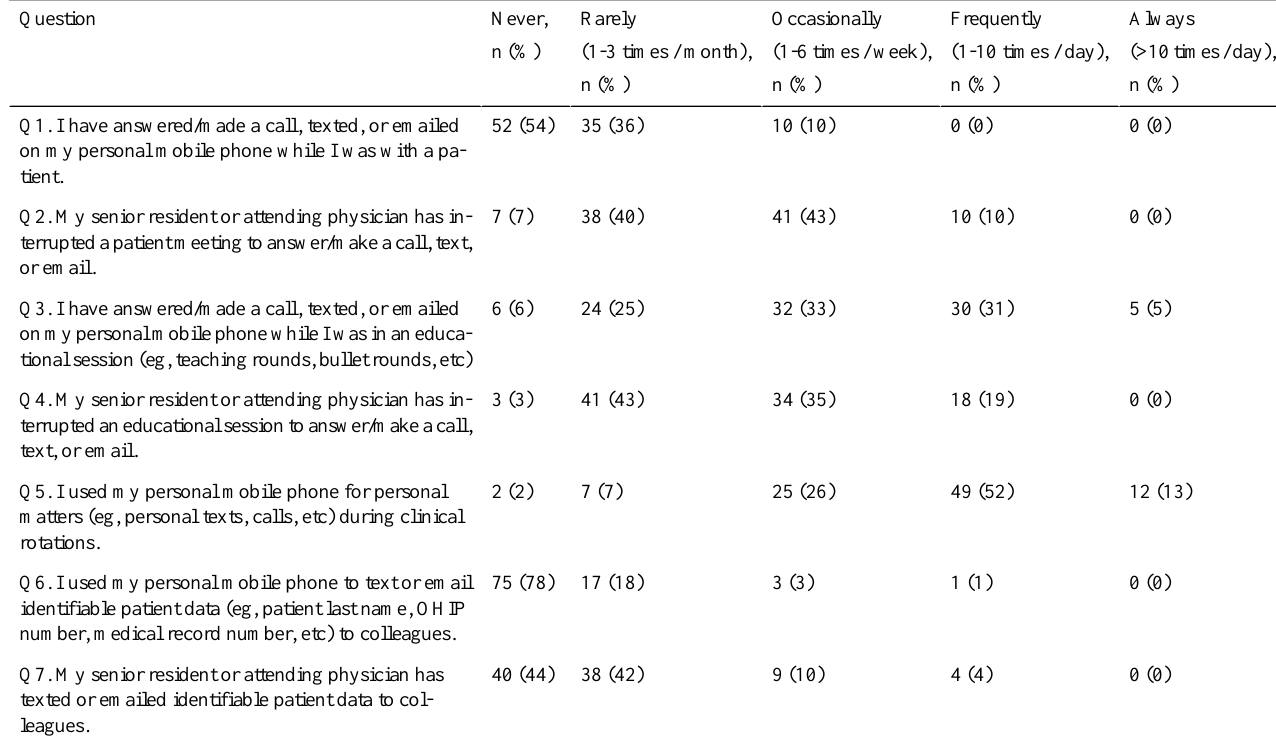
Always (>10 times / day), n